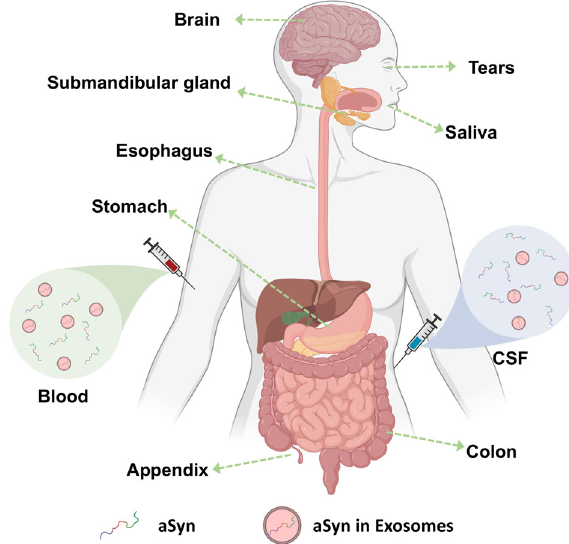
Fig. 1 Overview of the localization of aSyn in the human body. Expression of aSyn has been detected in brain tissue, in peripheral tissues as well as in biological fl uids. Speci fi cally, in body fl uids (blood and CSF), aSyn is circulated both as a free protein and/or exosomes-inbound protein. Created with